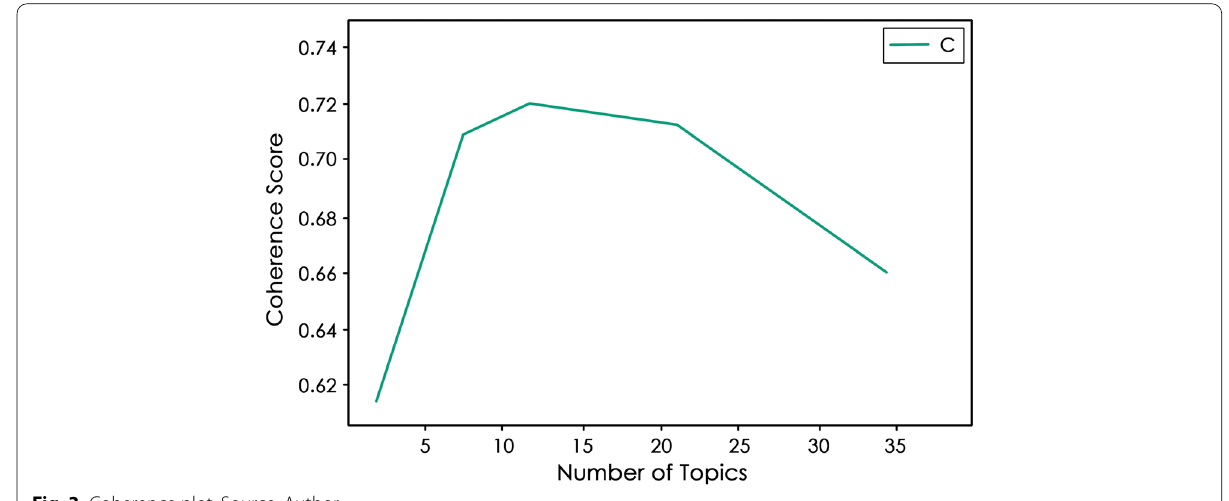
Fig. 3 Coherence plot. Source: Author